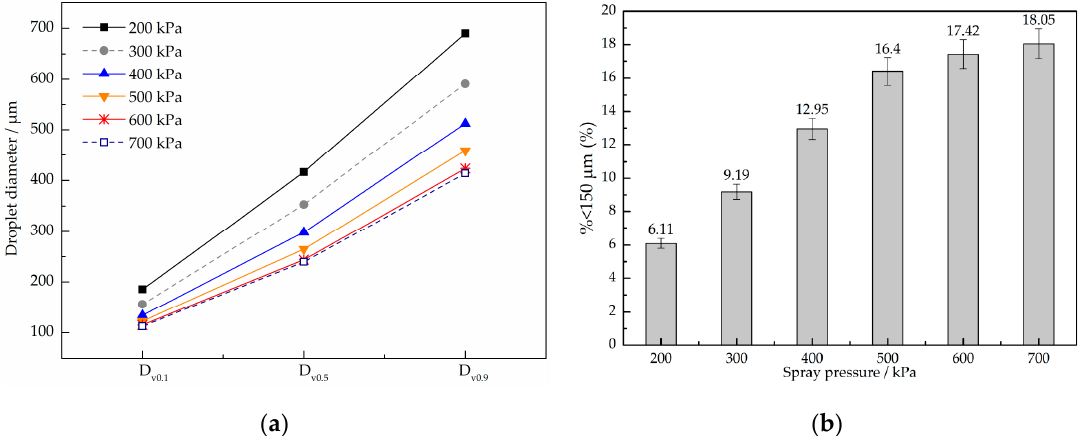
Figure 2. ( a ) Volumetric diameters below which smaller droplets constitute 10%, 50% and 90% of the total spray volume (D v0.1 , D v0.5 and D v0.9 ) and ( b ) proportion of the spray volume contained in droplets with a diameter below 150 µm (% < 150 µm) for 11001 under different spray pressures (200~700 kPa) at an air velocity of 3 m/s.